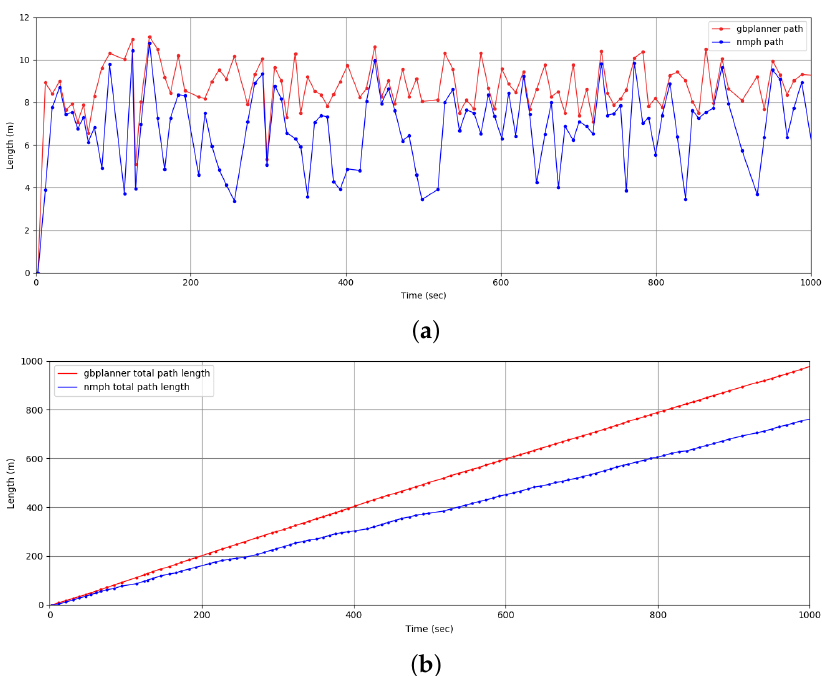
Figure 14. Comparison of path lengths between graph-based planner and our proposed NMPH path planner. ( a ) Path length between stabilization points. ( b ) Total length of generated paths.